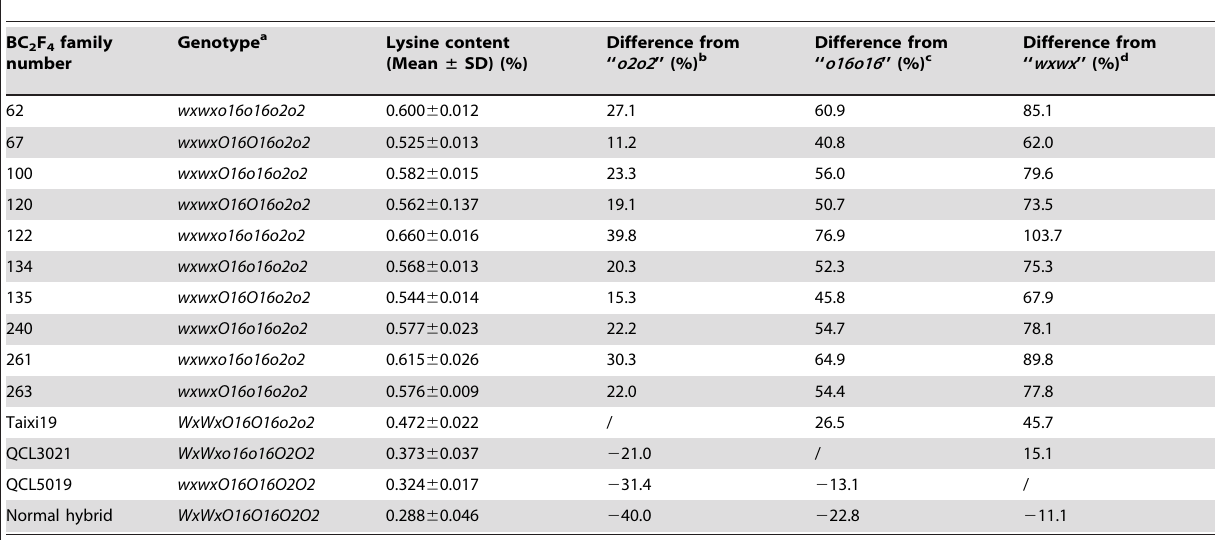
Table 8. Lysine content of 10 selected families BC 2 F 4 seeds and their parental